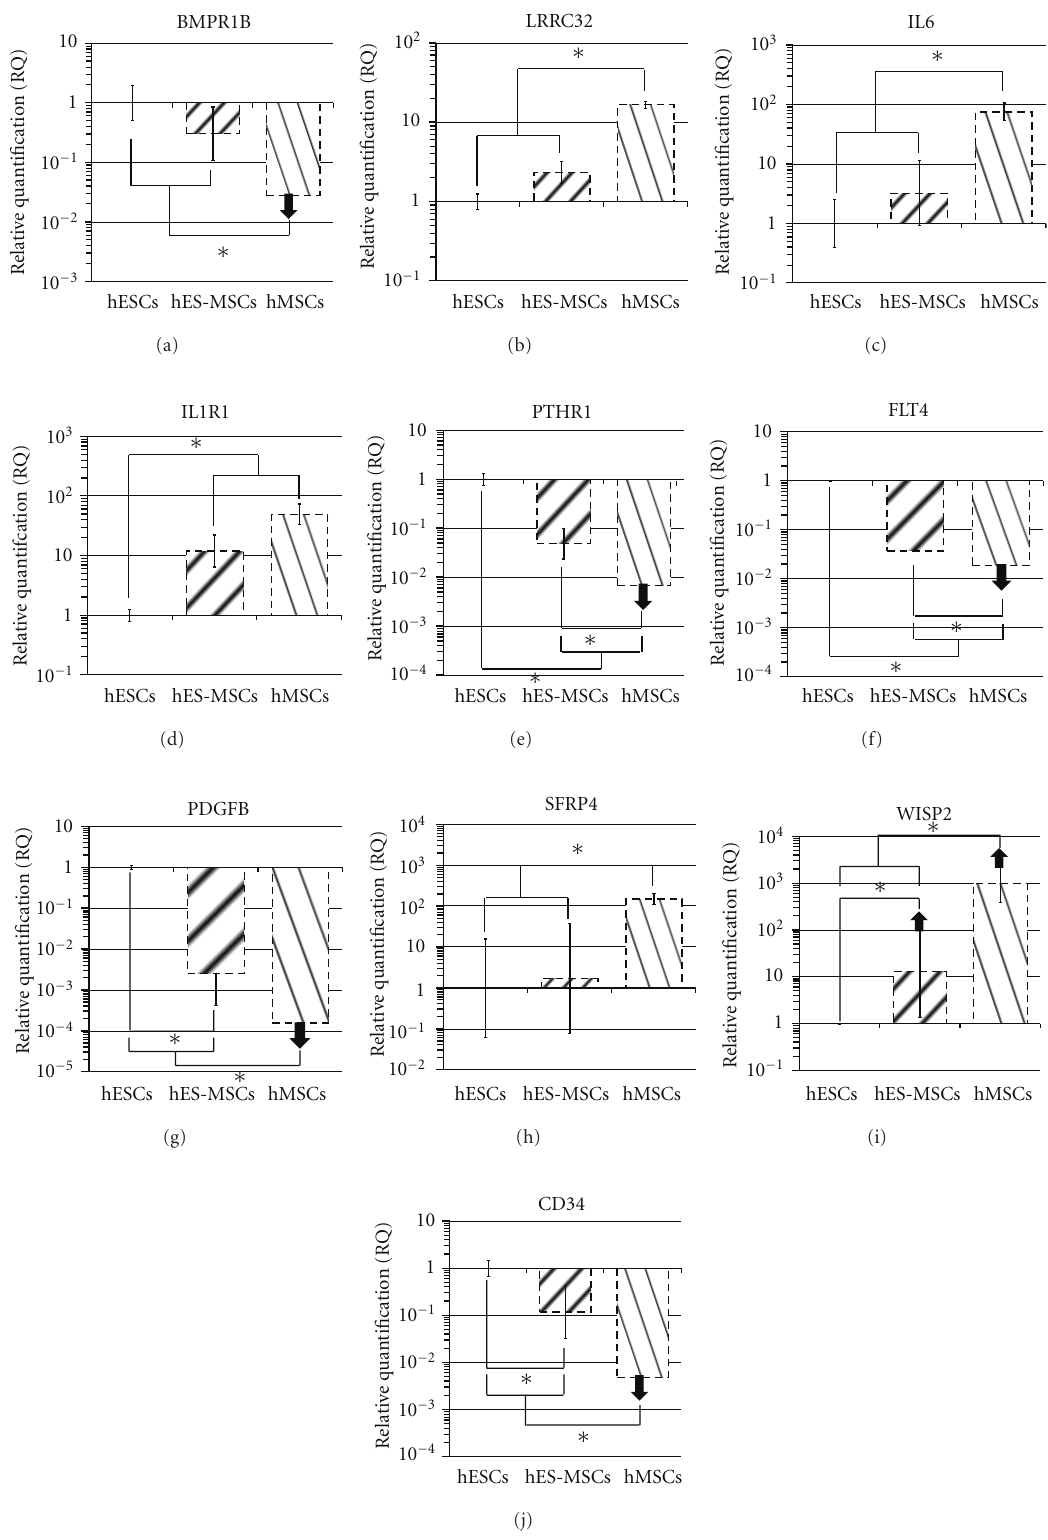
Figure 3: Transcriptomic expression analyses of potential markers for primitive hMSC selection. Relative gene expression of hESC-derived hMSC (hES-MSC) or hMSC populations compared to hESC calibrator group. Messenger RNA levels were determined using QRT-PCR, and relative quantification (RQ) values were calculated by the 2 − ΔΔ Ct method with GAPDH as internal control and an arbitrary threshold at 35 cycles. Asterisks ( ∗ ) indicate significant expression variation with P value < 0.05. As compared to hESC calibrator group, arrows pointing downwards ( ↓ ) indicate gene extinction ( > 35Ct) and arrows pointing upwards ( ↑ ) indicate gene appearance ( <